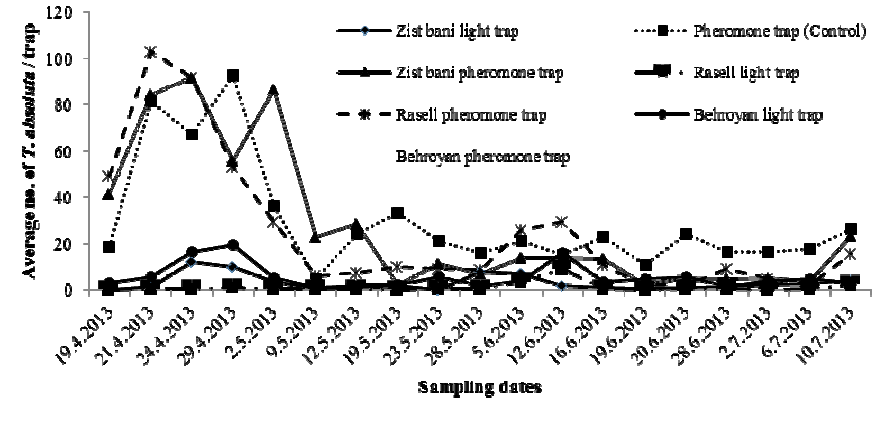
Fig. 1. Population fluctuations of T . absoluta in experimental tarps in various sampling